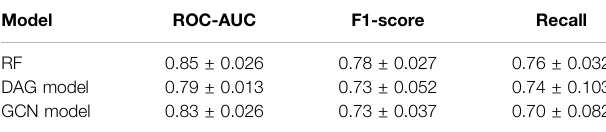
TABLE 2 | Tenfold cross-validation results for the best classi fi ers. Scores are presented as mean values ± SD based on 10 iterations.